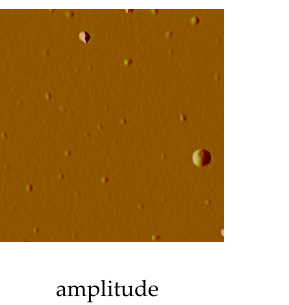
µ -O 2 (EtNH 2 ) 2 ( 2 CC 2 F 5 ) 4 ] ( 2 )/Si, Mag = 5